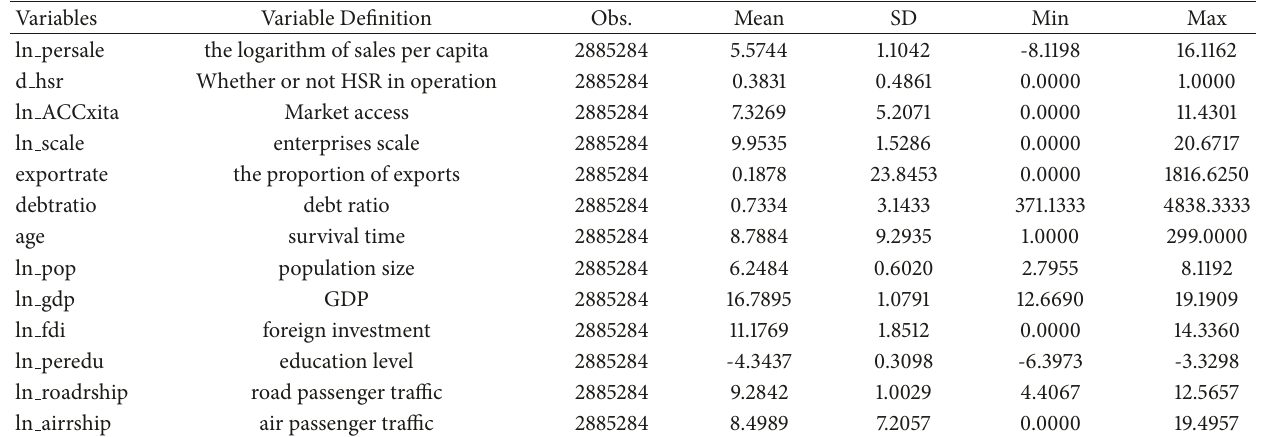
Table 2: Descriptive statistics of key